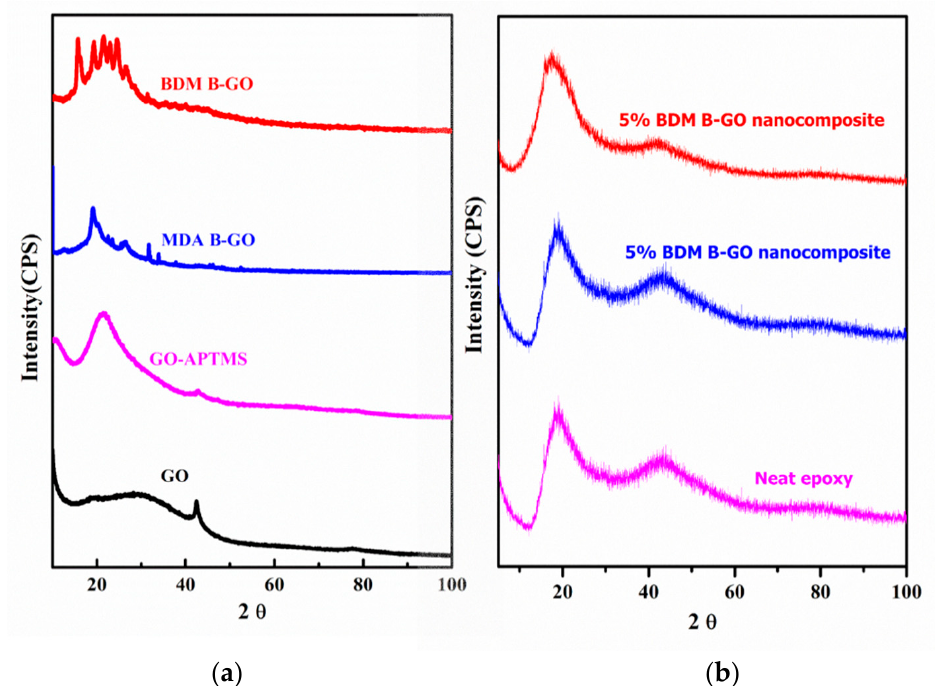
Figure 7. XRD pattern of ( a ) GO, GO-APTMS, MDA-B-GO and BDM-B-GO oligoimides ( b ) Neat epoxy and its nanocomposites.